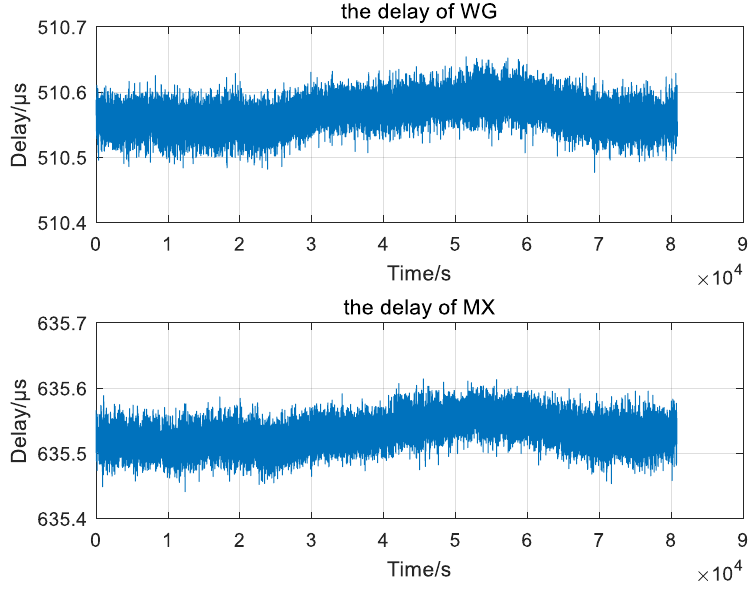
Figure 9. Delay measurement in Wu. Gong (WG) and Mei. Xian (MX).